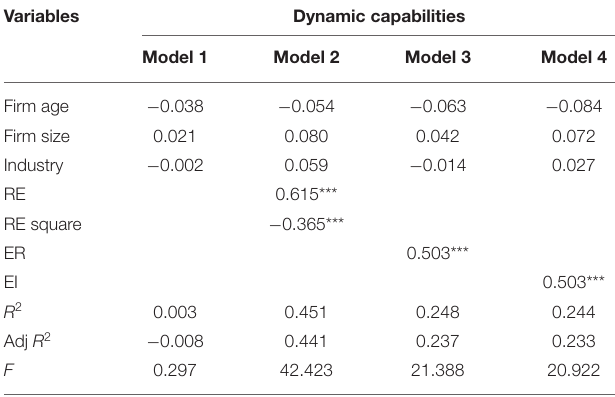
TABLE 3 | Regression results of direct